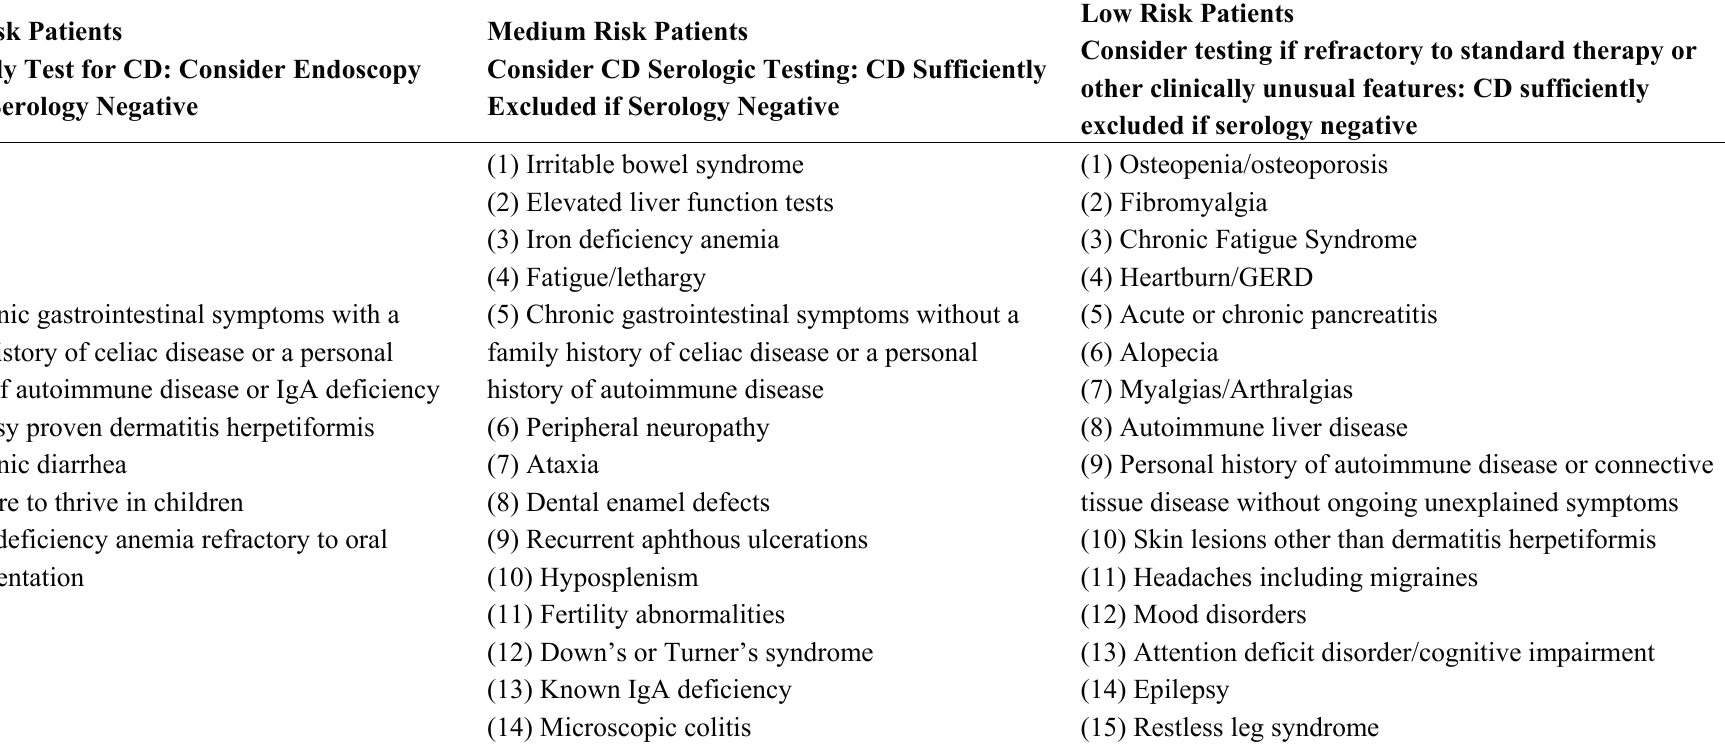
Table 1. Who should be tested for CD